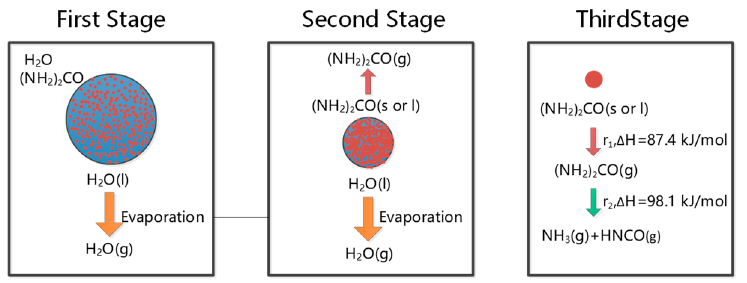
Figure 2. Urea pyrolysis mechanism.